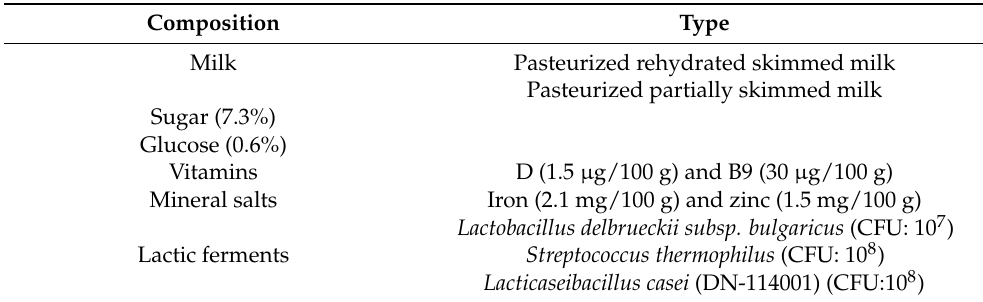
Table A1. Composition and microorganisms present in the commercial preparation Actimel ® . CFU: colony-forming